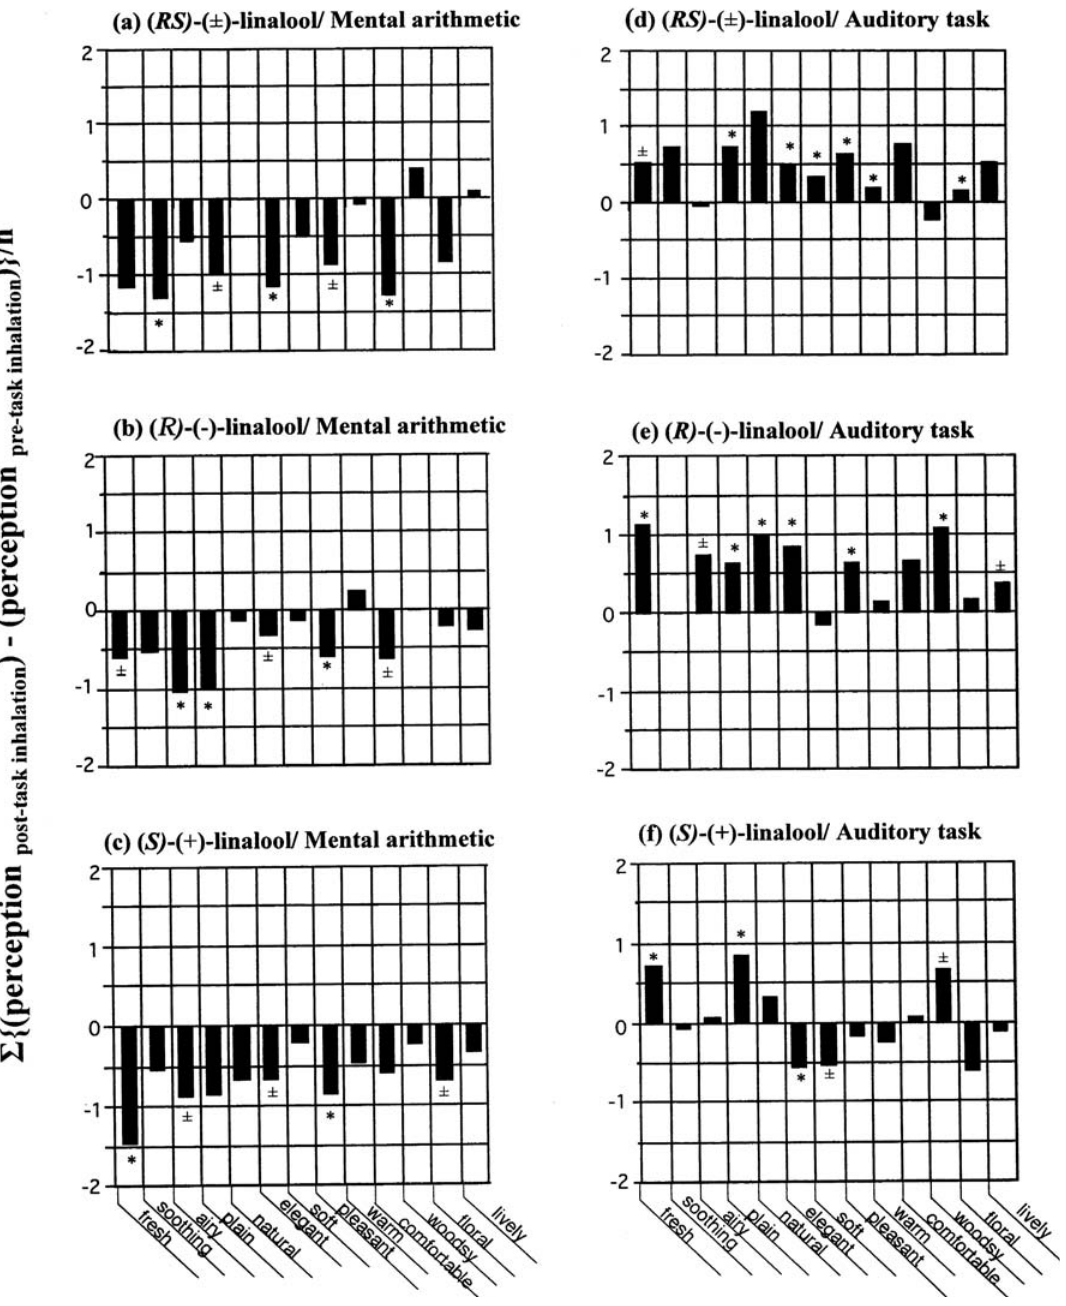
Figure 2. Sensory spectra of enantiomers of linalool [( RS )-(±)-, ( R )-( − )- and ( S )-(+)-forms] as a function of behavioural task. ( a ) ( RS )-(±)-linalool, ( b ) ( R )-( − )-linalool and ( c ) ( S )-(+)- linalool when the subjects undertaking mental arithmetic; and ( d ) ( RS )-(±)-linalool, ( e ) ( R )- ( − )-linalool and ( f ) ( S )-(+)-linalool while undertaking the auditory task. Concentration of enantiomer was every 20 mg/mL (in diethyl phthalate), which was loaded and moistened in an inhalator (300 mL vol.) by applying 200 μ L of each solution. Number of subjects